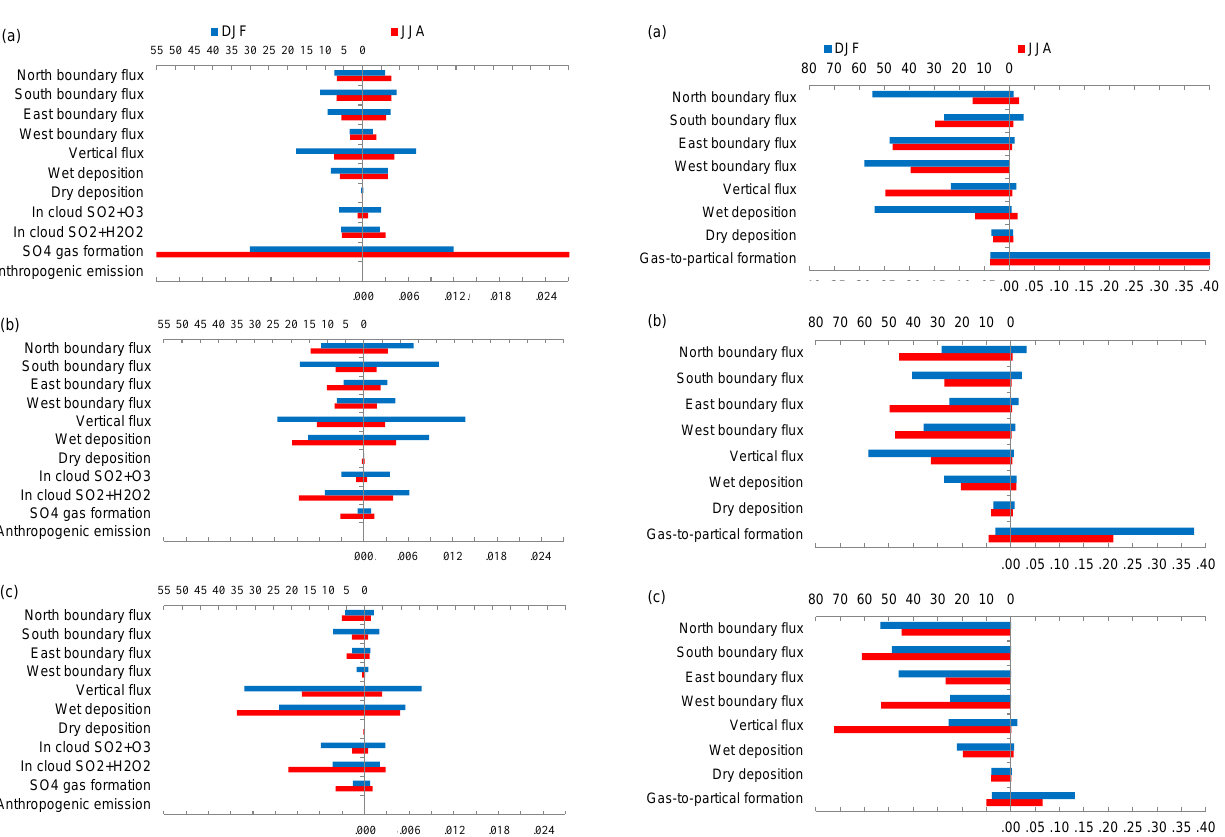
Figure 11. Nitrate budget (mass flux from each process in TgNseason − 1 , right) and APDM of each flux (%, left) in (a) NC, (b) SC, and (c) SCB obtained from simulation ANNmet. Blue lines are for DJF and red lines are for JJA. Transport fluxes were calcu- lated at the boundaries while other sources and sinks were calcu- lated as the sums over the grid cells of the region under